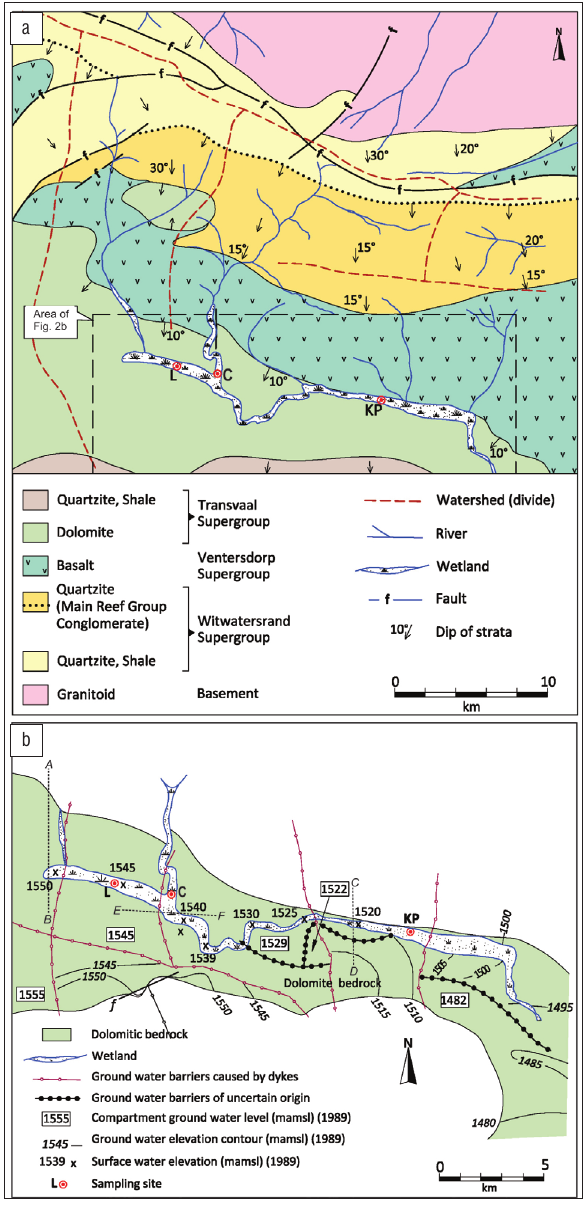
Figure 2: Maps showing (a) the simplified geology in the study area, (b) groundwater elevation and major barriers to groundwater movement in the upper Klip River Basin. 19